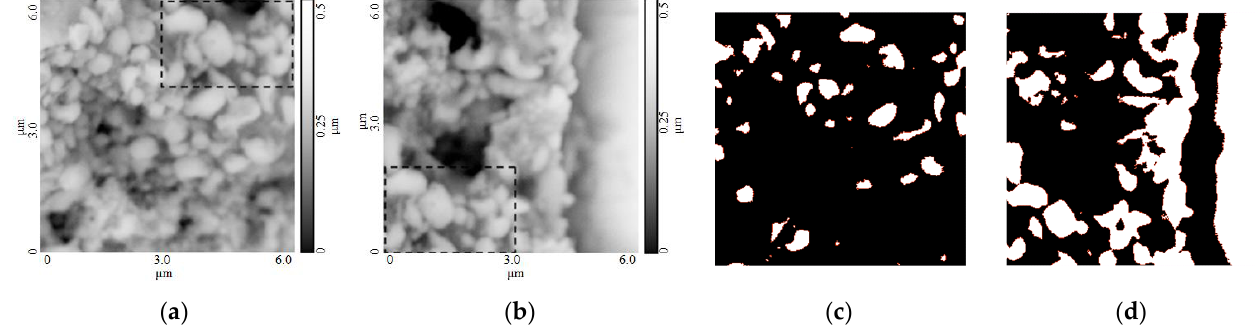
Figure 5. Overlapping fullerene’ images (256 × 256 pixels): ( a , b ) source images with marked overlap area; ( c , d ) the results of segmentation by GrainAnalysis.